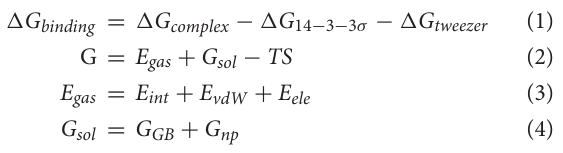
FIGURE 1 | Topological depictions for 14-3-3 σ monomer and tweezer molecule. (A) Structure of tweezer molecule. (B) Definitions for helices of 14-3-3 σ . Cartoon style used for 14-3-3 σ . The helix is defined as α 1, α 2, α 3, α 4, α 5, α 6, α 7, α 8, and α 9 from N-terminal to C-terminal of 14-3-3 σ (PDB entry code